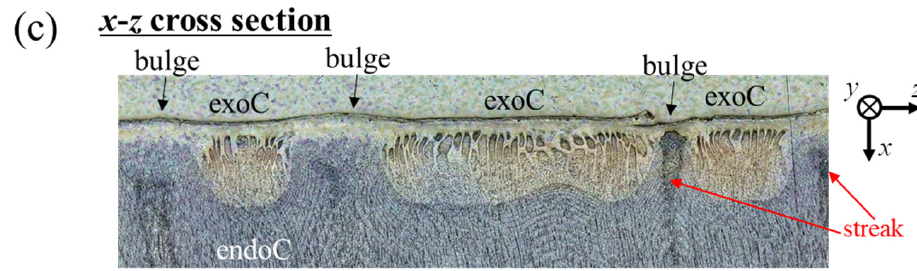
Figure 2. ( a ) Palm of the right claw of the mud crab used, and laser scanning microscope images of cross sections of ( b ) the x - y plane and ( c ) x - z plane on the mottled, deep-blue area observed through a 3D laser scanning microscope. Here, exoC denotes the exocuticle, and endoC denotes the endocuticle.